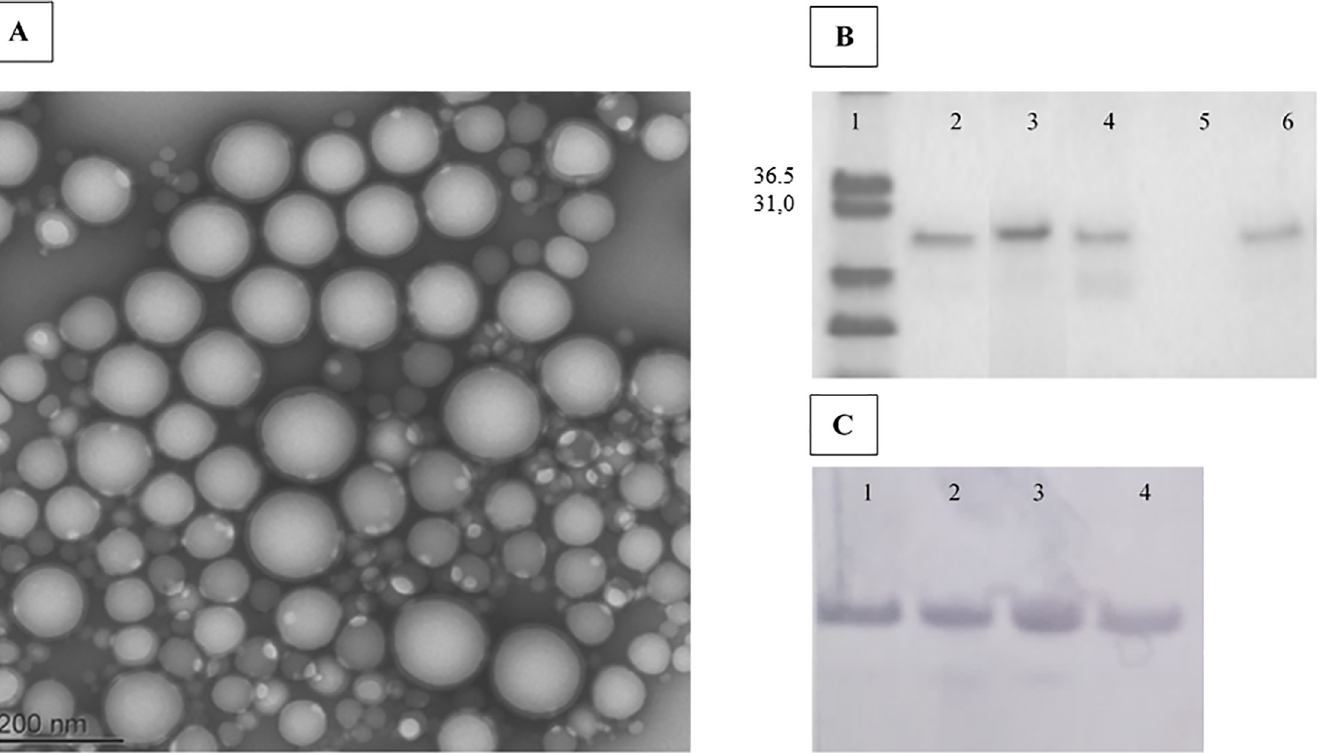
Fig 1. Nanoparticles characterization. (A) Transmission electronic microscopy image of the Eg Trp-NPs-MPLA formulation. (B) SDS page analysis after Coomassie Blue staining of Eg Trp extracted from NPs. line 1: molecular weight marker), line 2: Eg Trp (positive control), line 3: Eg Trp treated with acetonitrile (control of extraction step), line 4: total Eg Trp-NPs-MPLA suspension after treatment with acetonitrile, line 5: supernatant, line 6: pellet of NPs after treatment with acetonitrile. (C) Western blot analysis of Eg Trp extracted from NPs and revealed with an anti- Eg Trp rabbit serum. line 1: Eg Trp treated with acetonitrile (control), lines 2, 3 and 4: Eg Trp obtained after treatment with acetonitrile of 3 different preparations of Eg Trp-NPs-MPLA.